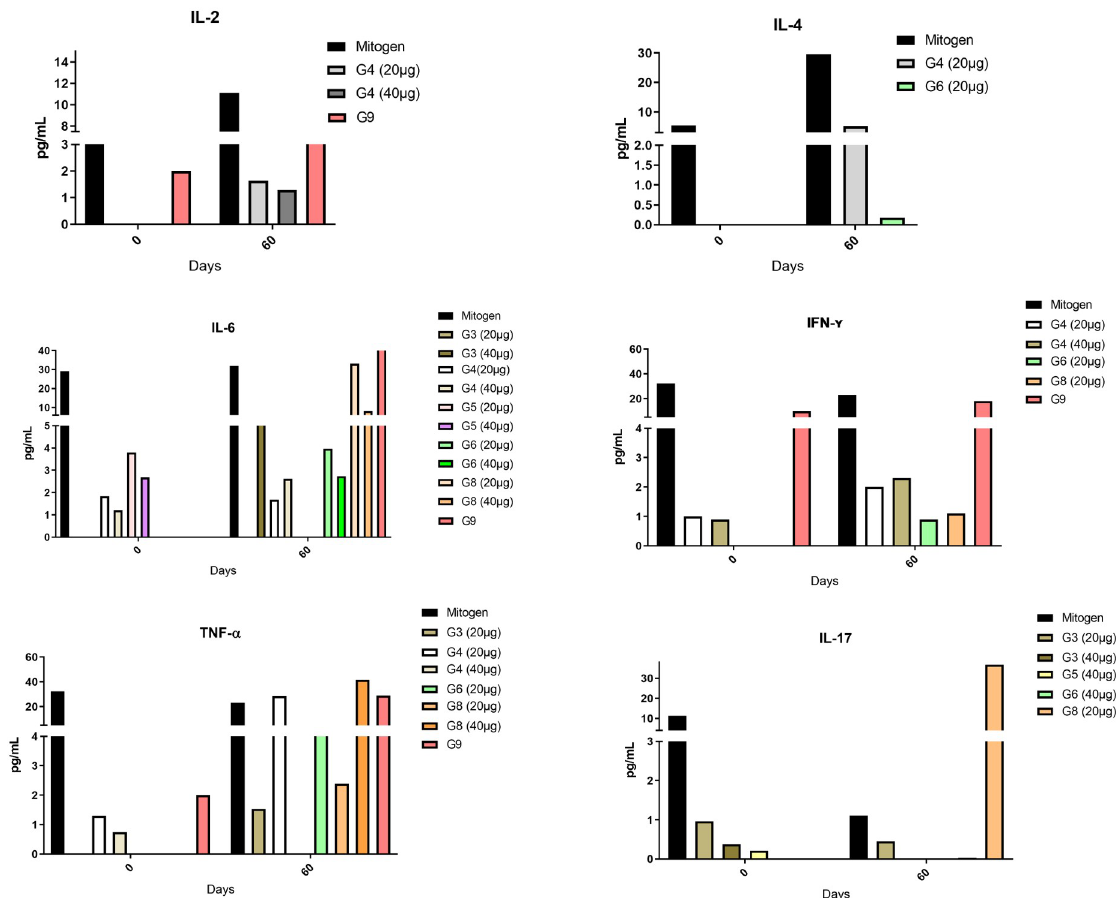
Fig 9. Cytokines profile of mice immunized with different peptides and their control. Thirty days after the last immunization with peptides vaccines, one mouse each group was euthanized and were spleen removal. The splenocytes were isolated and assayed for the production of IL-2, IL-4, IL-6, IFN- γ , TNF- α , IL-17, and IL-10 by flow cytometry and were used BD Cytometric Bead Array (CBA) mouse Th1/Th2/Th17 cytokine kit. The results are presented as mean ± standard error and were statistically evaluated by one-way ANOVA and Tukey’s post-test. G1—inoculated with PBS; G2—inoculated with Saponin; G3—inoculated with Peptide 1 + saponin; G4—inoculated Peptide 2 + saponin and G5—inoculated with Peptide 3 + saponin; G6—inoculated with Peptide 4 + saponin; G7—inoculated with